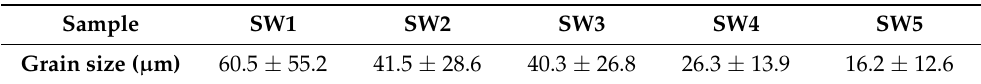
Figure 1. EBSD orientation maps of the extruded bar taken: ( a ) from the section perpendicular to the ED and ( b ) parallel to the ED. Table 1. Grain size of swaged